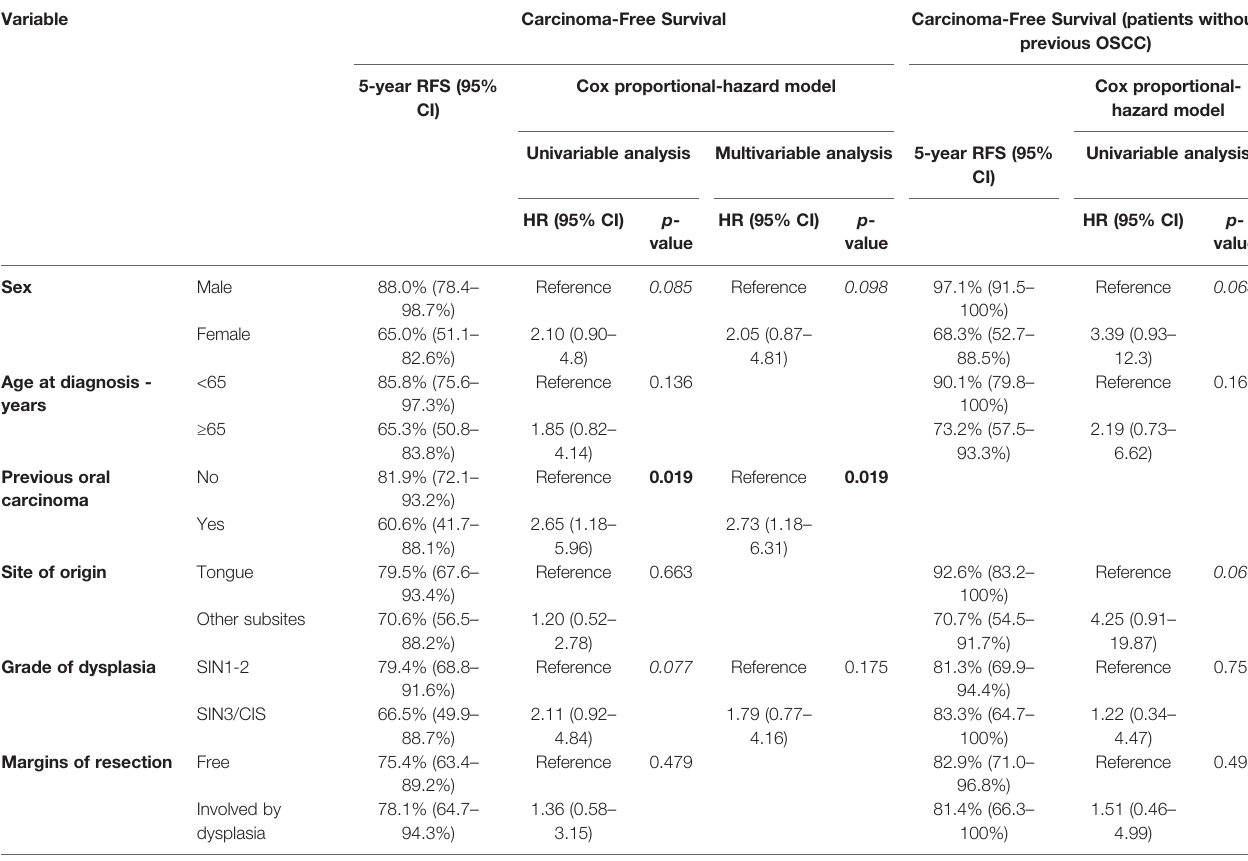
TABLE 4 | Uni- and multi-variable analysis of the most relevant demographics and clinical – pathological factors according to CFS (carcinoma-free survival).